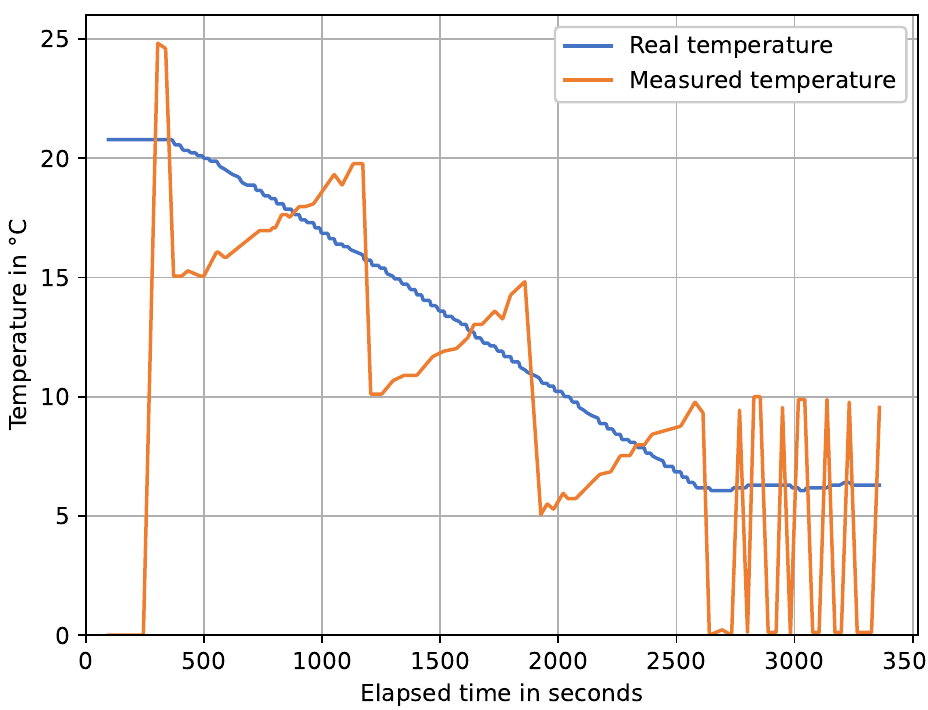
Figure 8. The measured temperature according to real temperature for the previous device